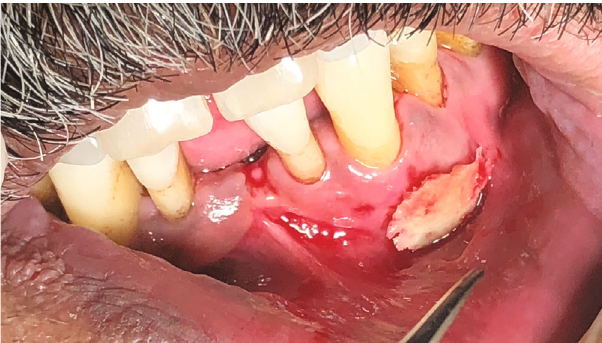
Figure 1: Intraoral picture of lesion in buccal vestibule of the mandibular left